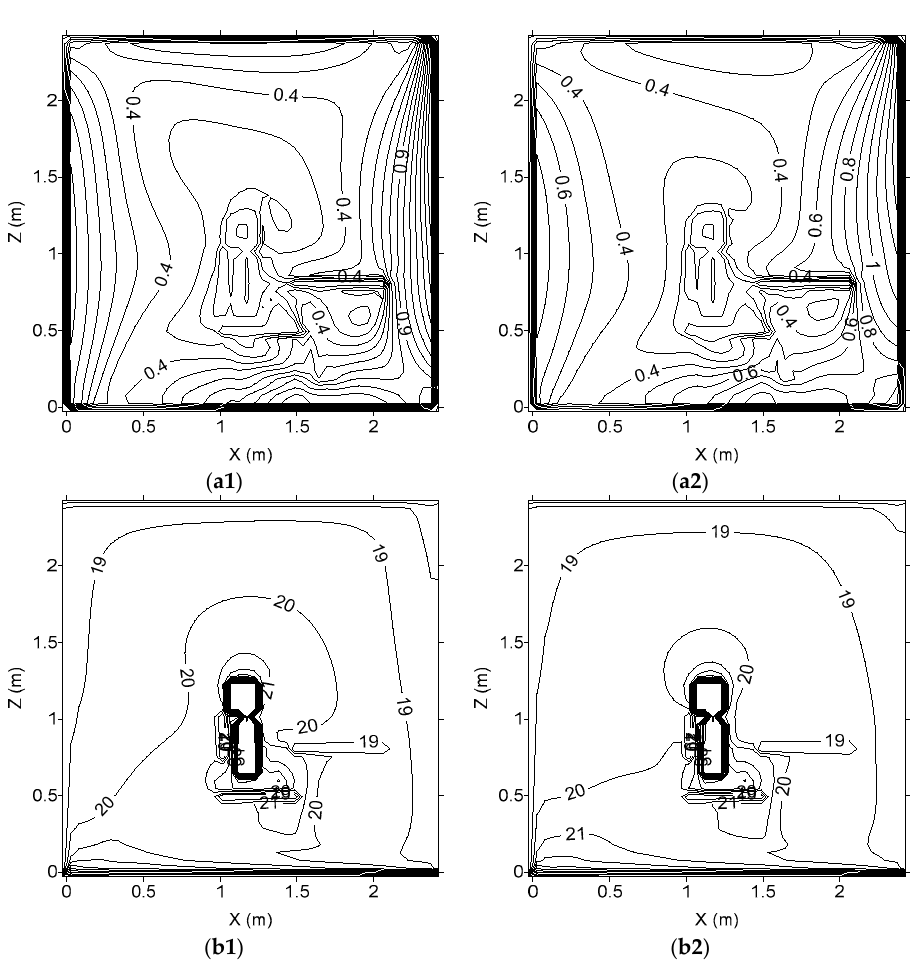
Figure 2. Air velocity ( a1,a2 ) and air temperature ( b1,b2 ) fields in the plan located at Y = 110 cm (Y22) (right side seated occupant), numerically calculated. ( a1,b1 ) are associated with the k ‐ epsilon turbulence model, and ( a2,b2 ) are associated with the RNG turbulence model.